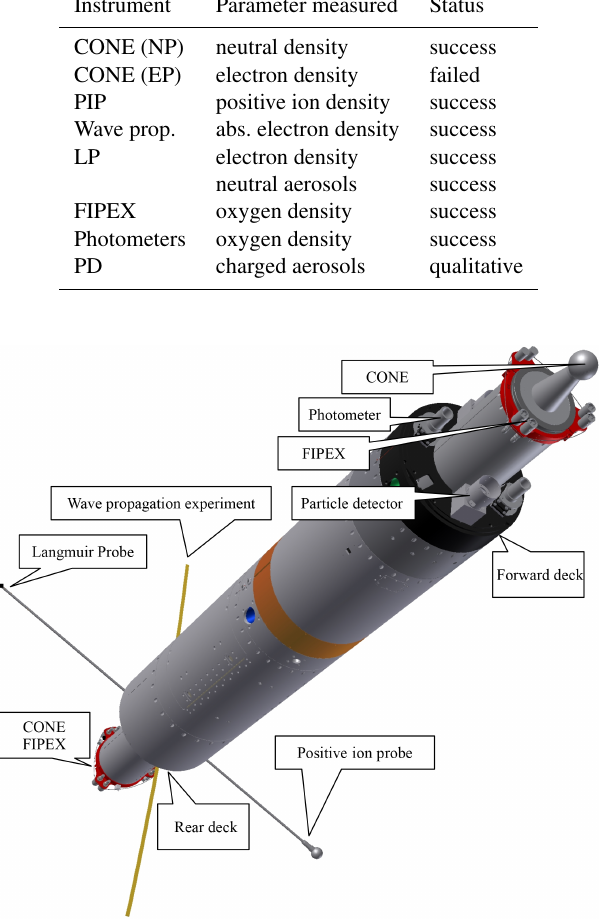
Figure 2. WADIS payload. See text for